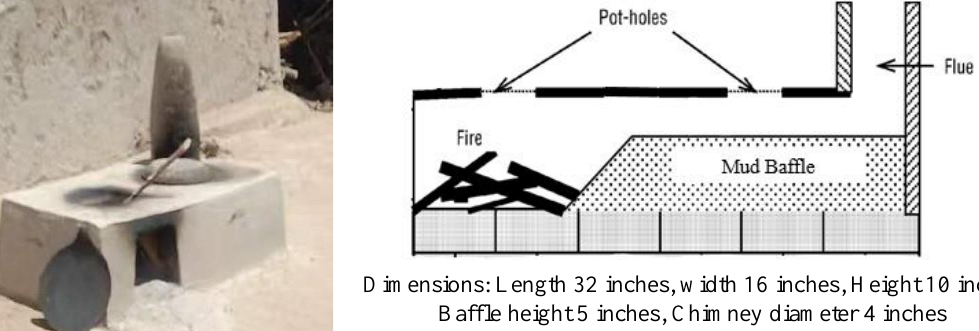
Figure 1. Improved cooking